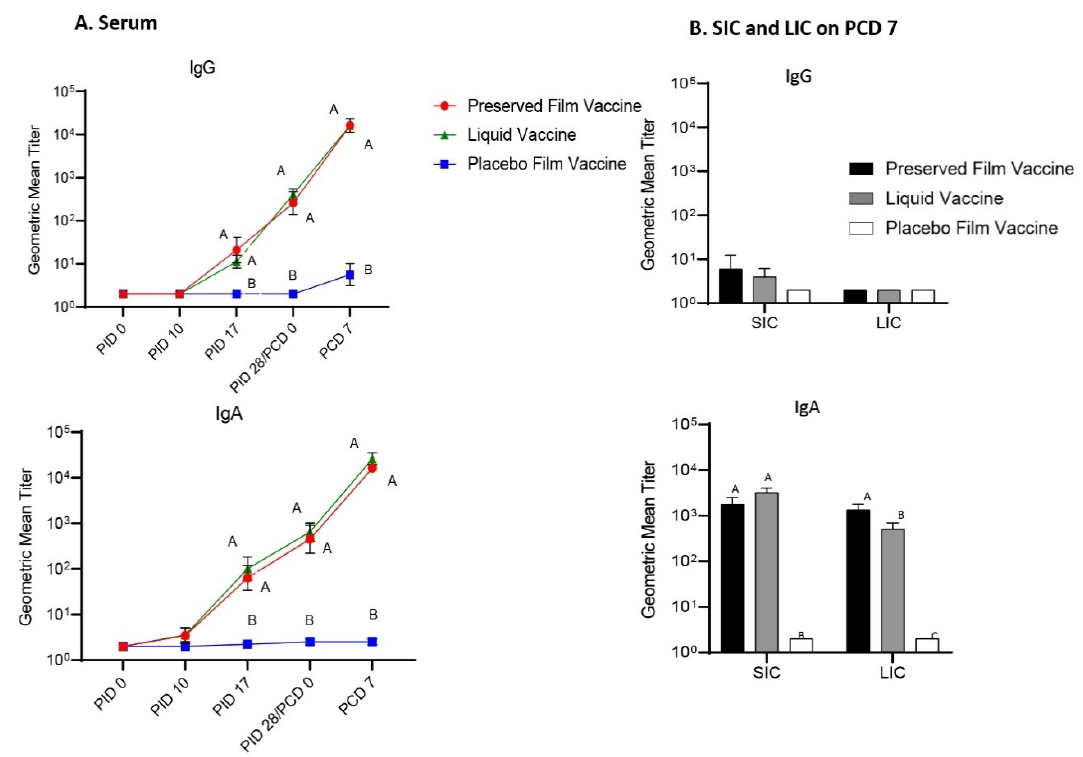
Figure 2. Geometric mean titers of Wa HRV-specific IgG and IgA antibodies in Gn pig serum samples collected at PID 0, PID 10, PID 17, PID 28, and PCD 7 ( A ), and in small intestinal contents (SIC) and large intestinal contents (LIC) collected on PCD 7 ( B ). Serum, SIC, and LIC samples were tested at a series of 4-fold dilutions, beginning at 1:4. All negative samples were given a titer of 2 to allow for data analysis and use in graphical depictions. Different capital letters (A, B, C) indicate significant differences ( p < 0.05) between groups, while shared letters indicate no significant difference. Data points without capital letters indicate no significant difference between any of the groups at that time point.